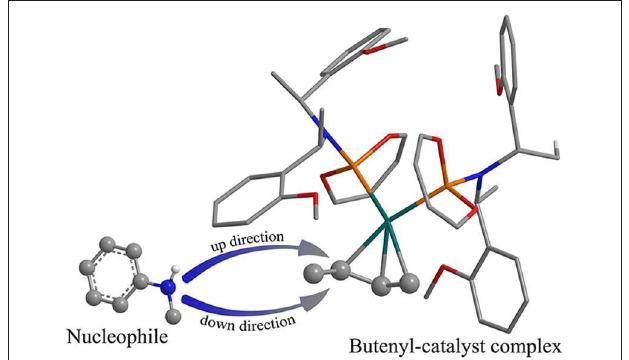
FIGURE 3 | The two attack directions of the nucleophile to approach the substrate